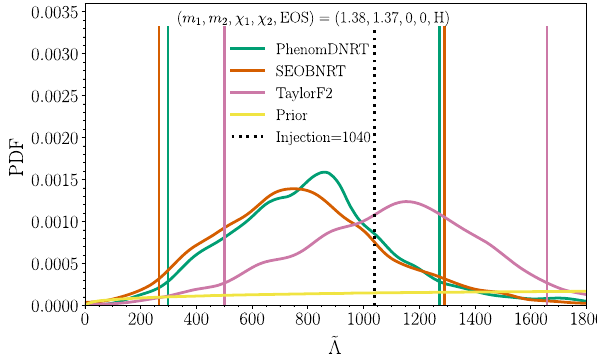
15. Same as Fig. 14 but with injection (iv) using the H EOS. Solid vertical lines represent the 90% HPD credible interval for each